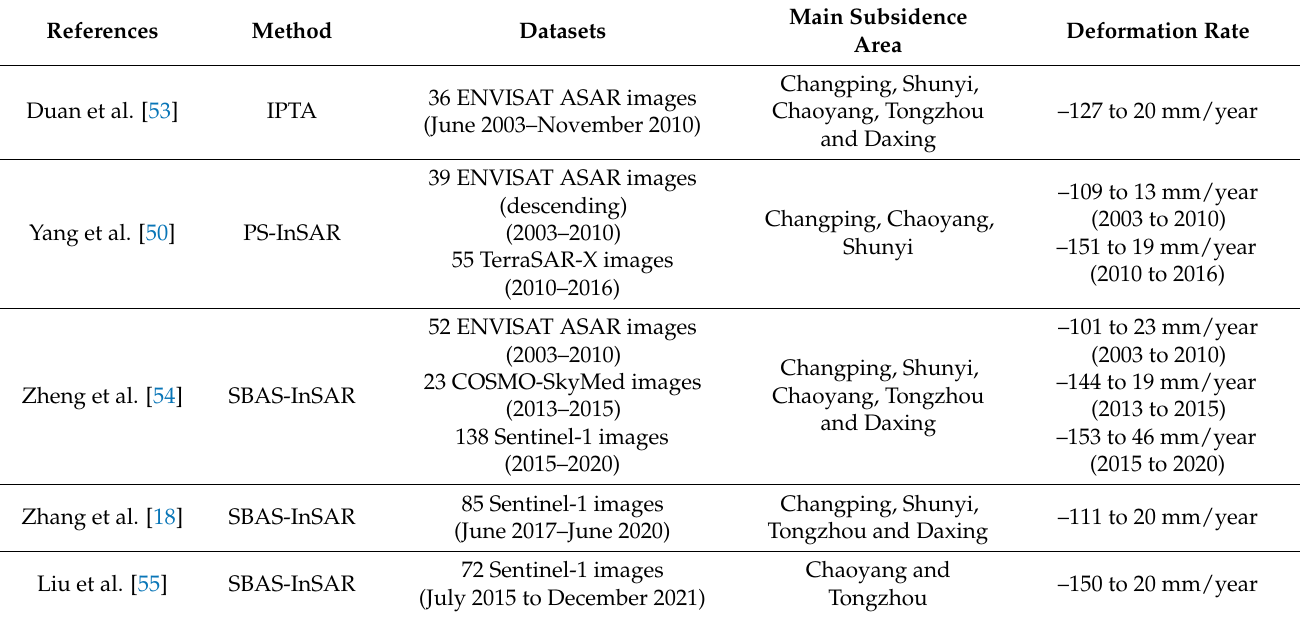
Table 2. Summary of the previous studies of surface subsidence in